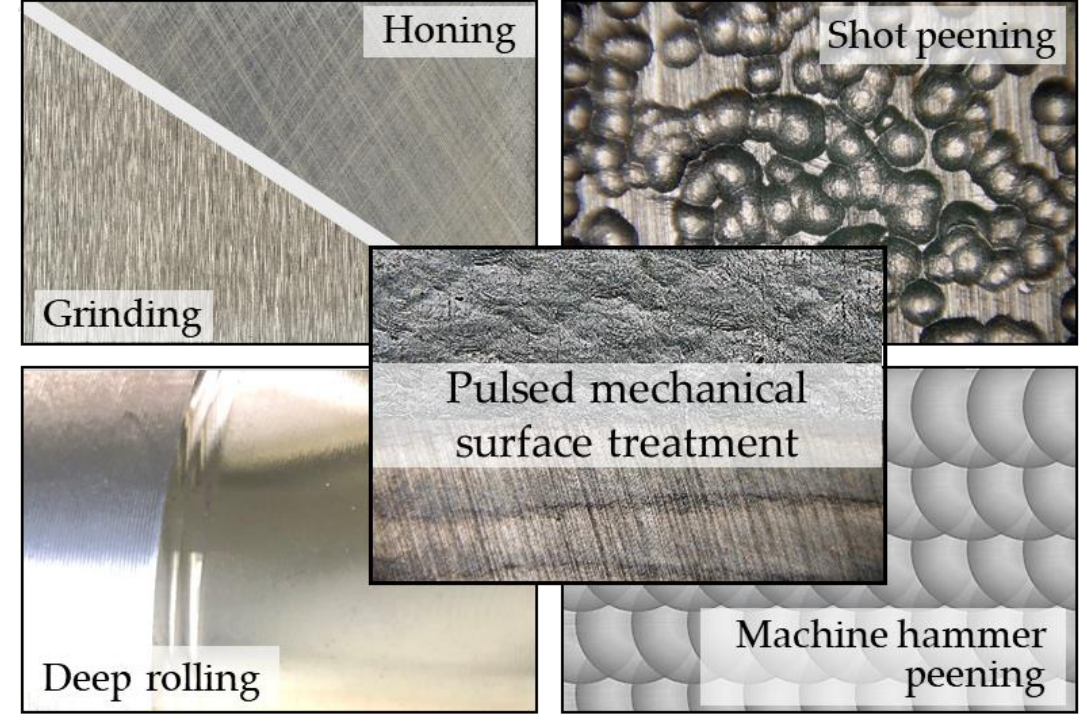
Figure 15. Different resulting surface topographies for grinding, honing, shot peening, deep rolling, machine hammer peening (exemplary), and classification of pulsed mechanical surface treatment. (Pictures by IWT Bremen).